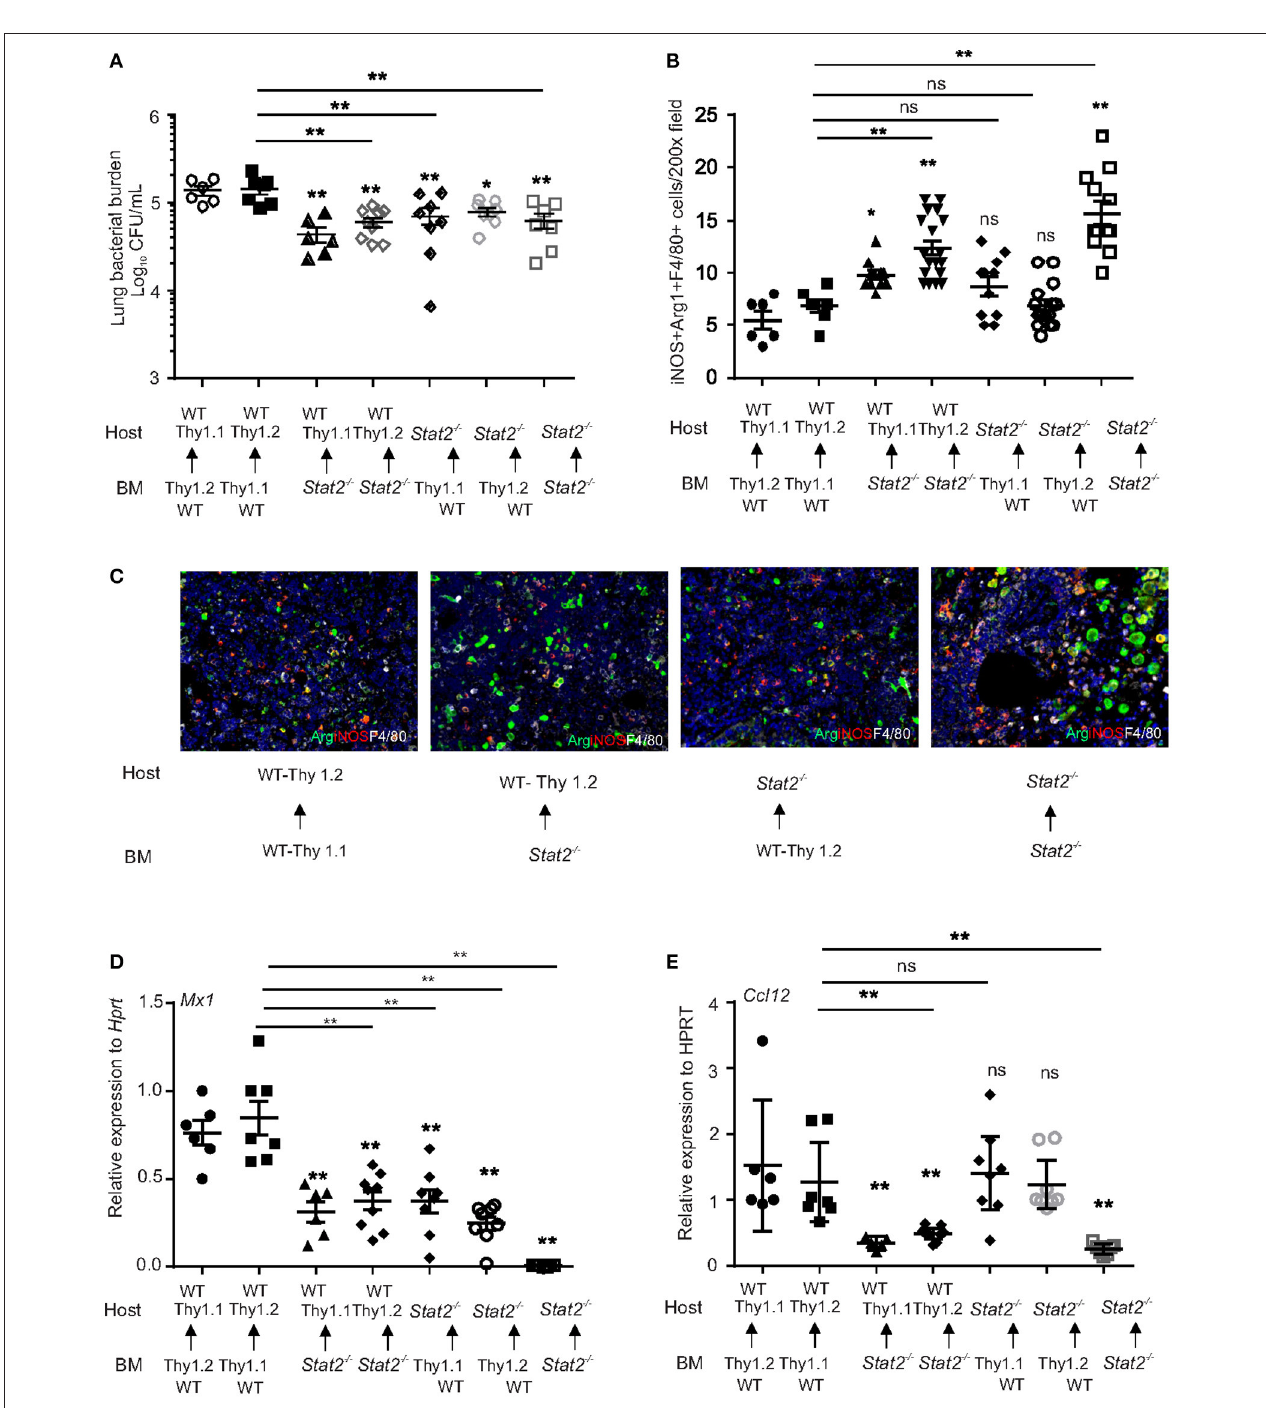
FIGURE 8 | Increased bacterial control in cells from hematopoietic or non-hematopoietic compartments of Stat2 − / − mice. WT BMC (Thy1.1 host, Thy 1.2 BM or Thy 1.2 host, Thy 1.1 BM), Stat2 − / − BMC ( Stat2 − / − host, Stat2 − / − BM), Hematopoietic Stat2 − / − BMC mice (Thy 1.1 or Thy 1.2 host, Stat2 − / − BM), non- hematopoietic Stat2 − / − BMC ( Stat2 − / − host, Thy 1.1 or Thy 1.2 BM) were generated as described in methods. These mice were infected with 100 PFU of influenza for 6 days then challenged with 5 × 10 7 cfu of MRSA for one additional day. (A) Mice were sacrificed and right upper lung lobes were homogenized in PBS and bacterial burden was measured. (B) iNOS + Arg1 + F4/80 + producing cells were determined from lung by immunohistochemistry, N = 6–19 per group. (C) Representative figures, × 200 magnification fields are shown. (D) Mx1 , (E) Ccl12 mRNA expression was measured, N = 6–9 per group. Data are represented as mean ± SEM. Data analyzed using One way ANOVA followed by Bonferroni test for multiple comparisons, * p < 0.05, ** p < 0.01, ns, not significant.